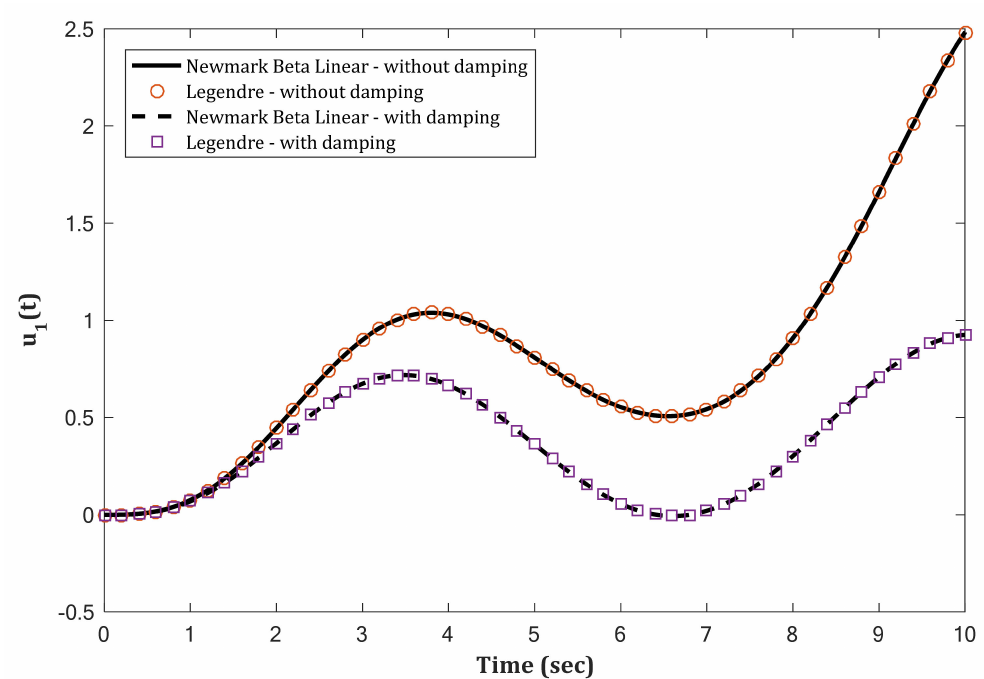
Figure 10. Forced vibration analysis of a 3DOF system. Comparison of u 1 ( t ) as a function of time, as obtained using the LGM method or the linear Newmark- β method.